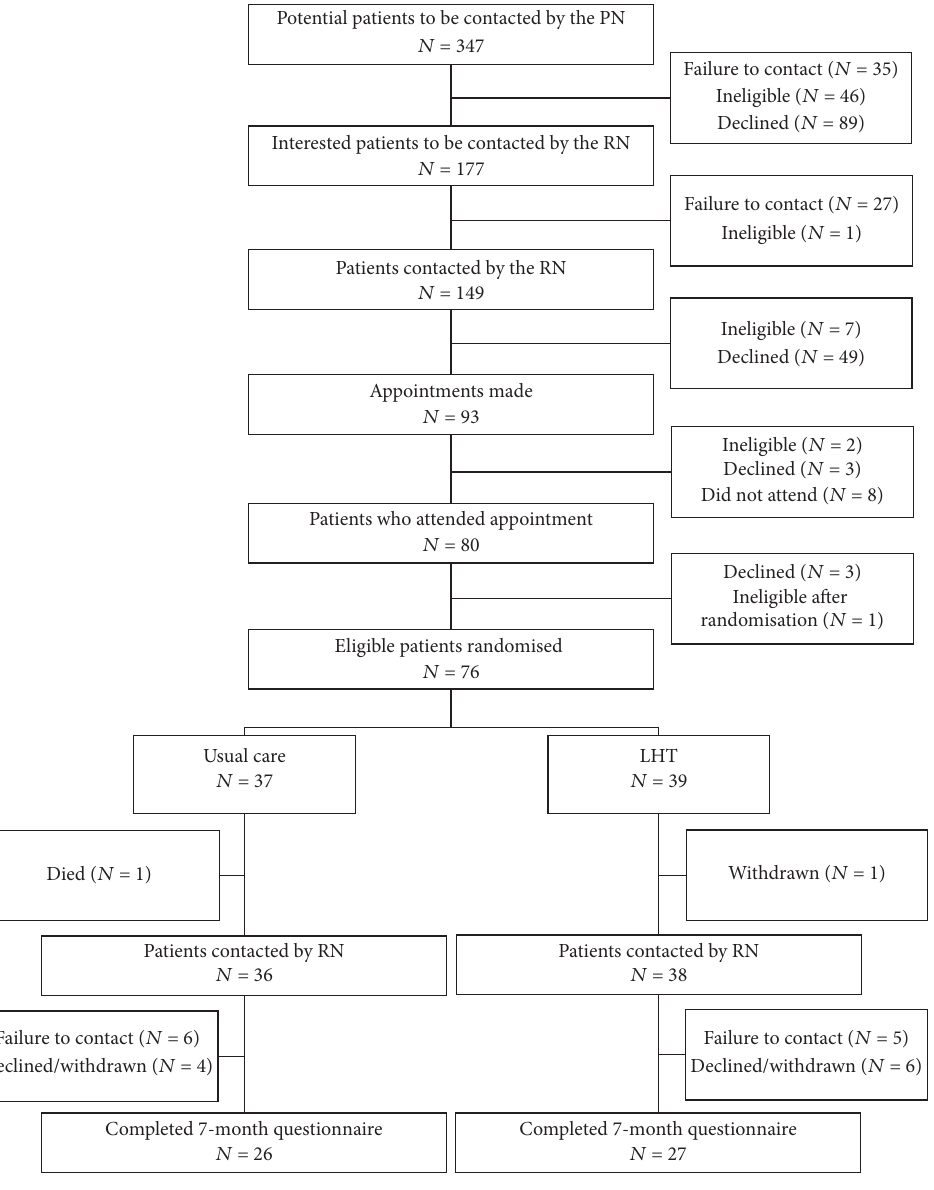
Figure 1: Consort